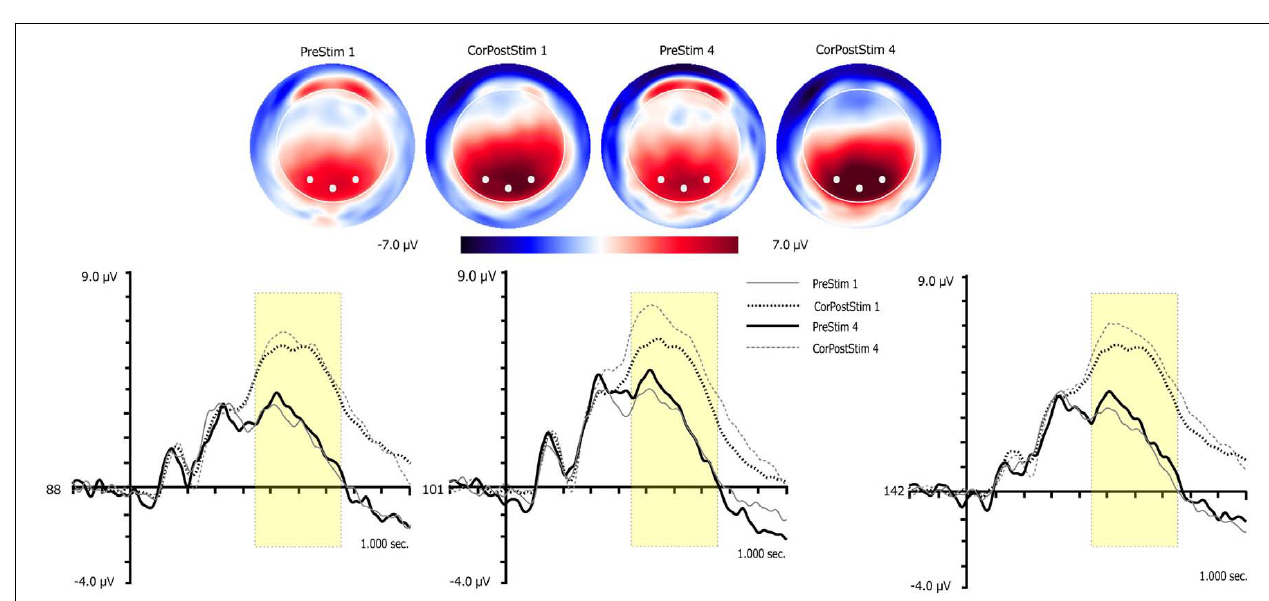
FIGURE 5 |Two dimensional topographic maps and waveform plots for pre-learned targets and correct post-learned go targets for sessions 1 and 4. Topographic maps are presented for the peak of the MFN. Orientation of maps is top looking down